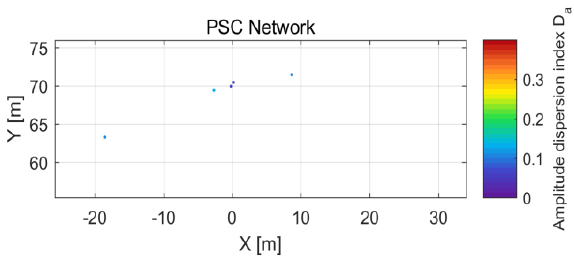
Figure 10. Result of selected PS points.